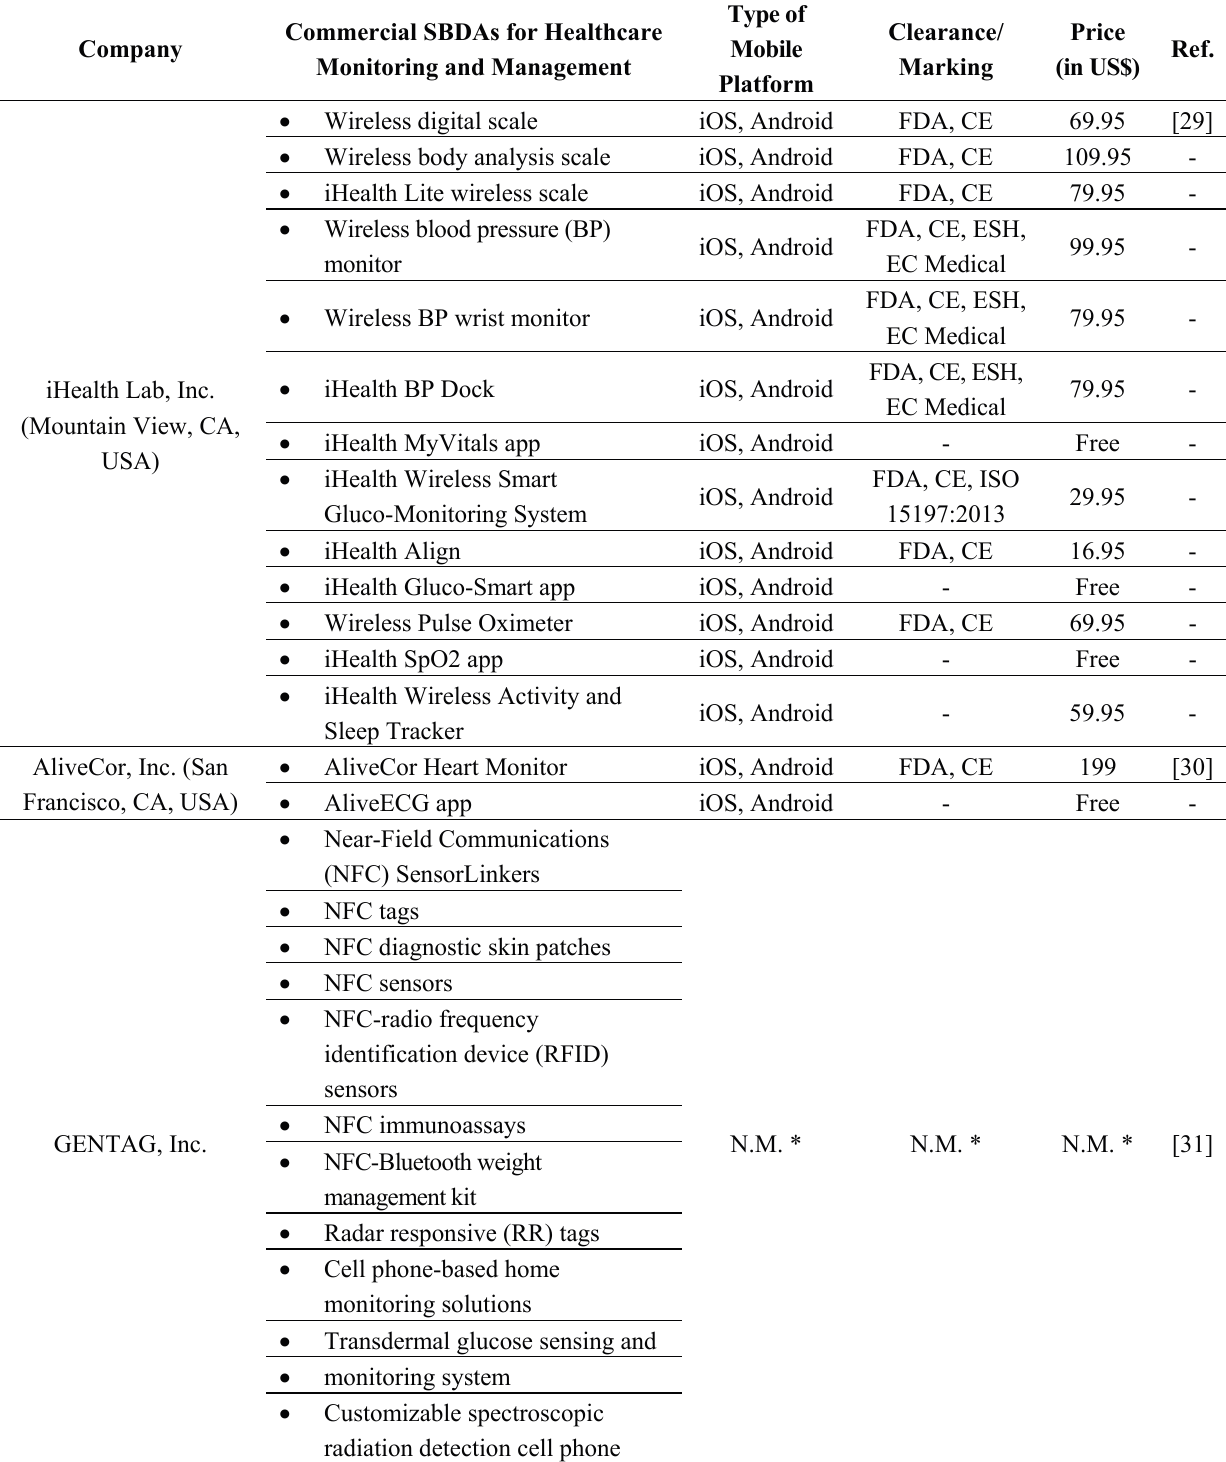
Table 1. Commercial smartphone-based devices and smart applications (SBDAs) for personalized healthcare monitoring and